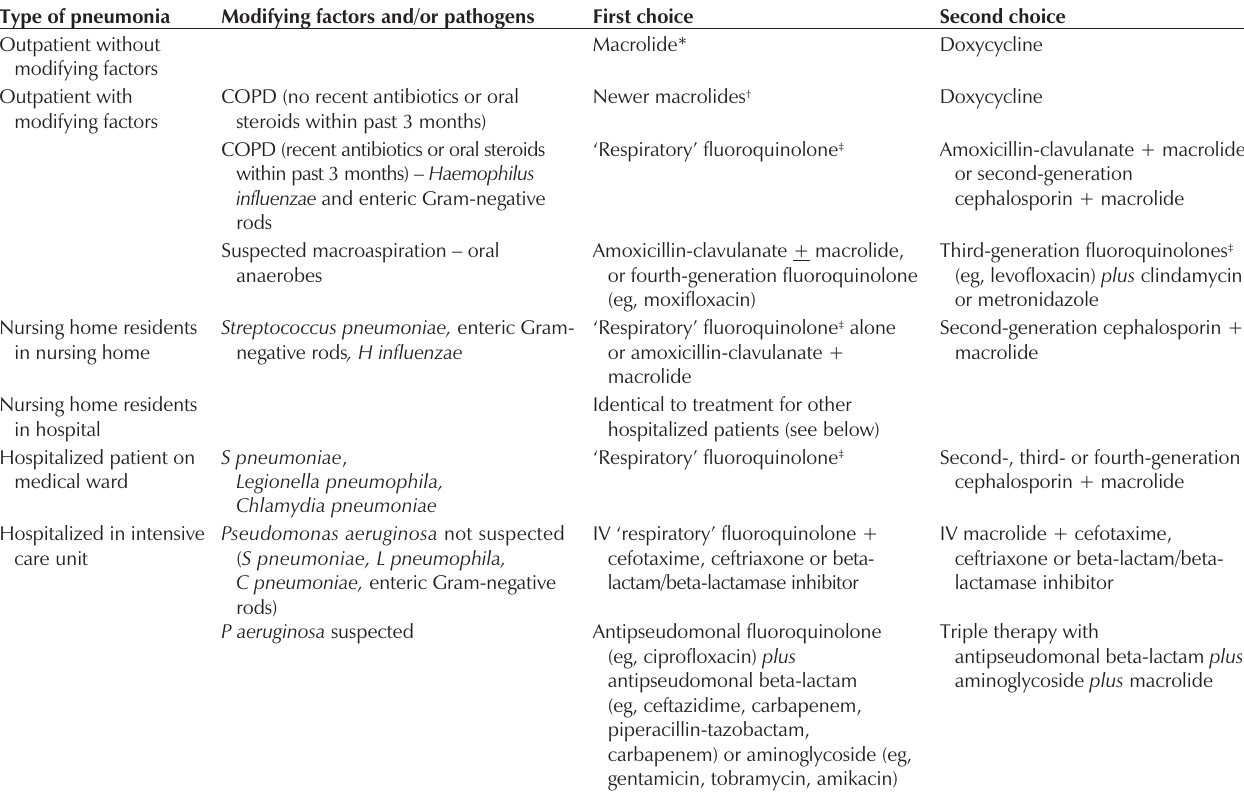
Empirical antimicrobial selection for adult patients with community-acquired pneumonia Type of pneumonia Modifying factors and/or